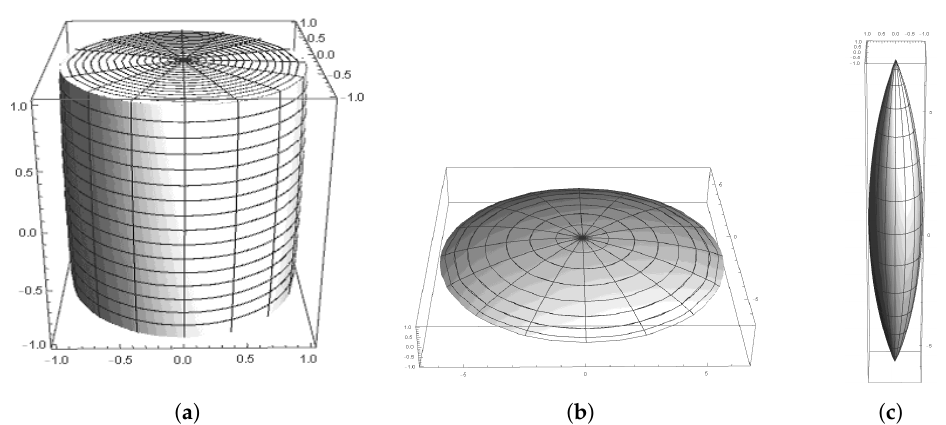
Figure 4. Some of the closed surfaces which are subsets of ξ γ ( S 2 ) for γ defined by Equation (6) (Figure 3). The anisotropic mean curvature for the outward-pointing normal is − 1: ( a ) Wulff shape W γ ; ( b ) a constant anisotropic mean curvature (CAMC) surface for γ ; and ( c ) a CAMC surface for γ